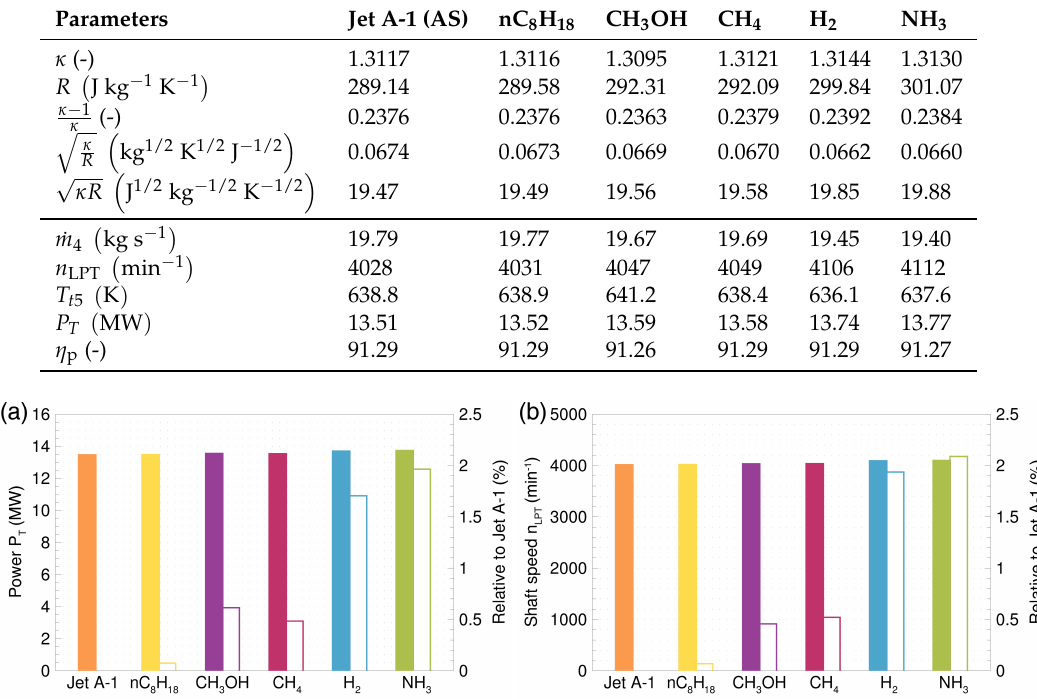
Table 7. Characteristic turbine performance parameters for different fuel types. Parameters